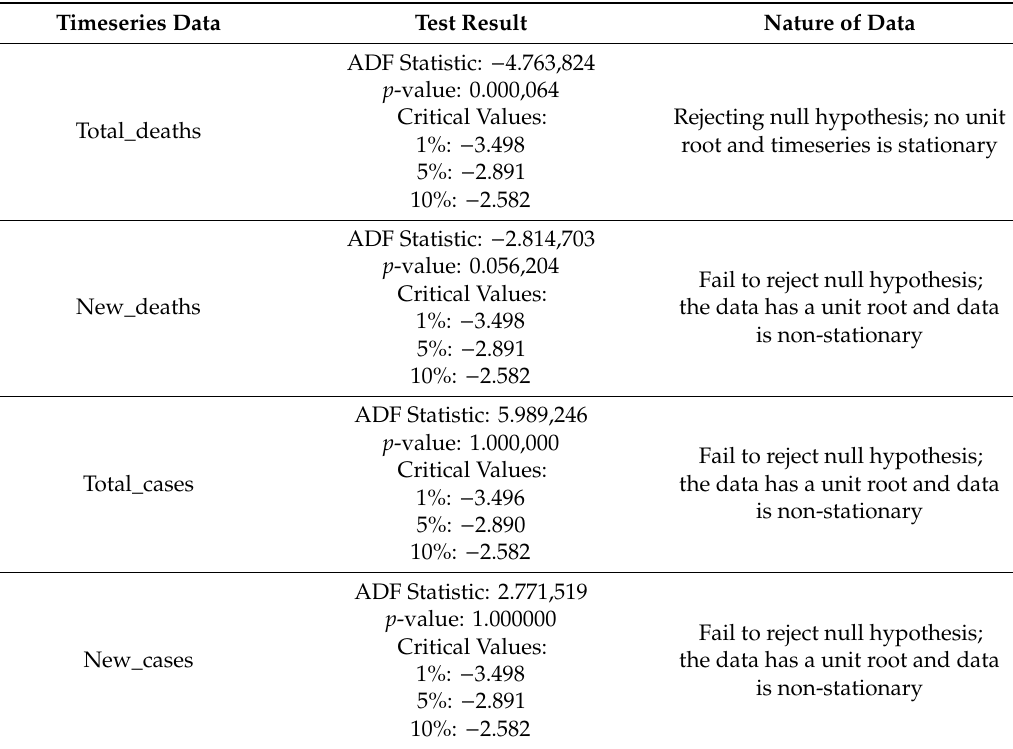
Table 10. Result of hypothesis testing of timeseries